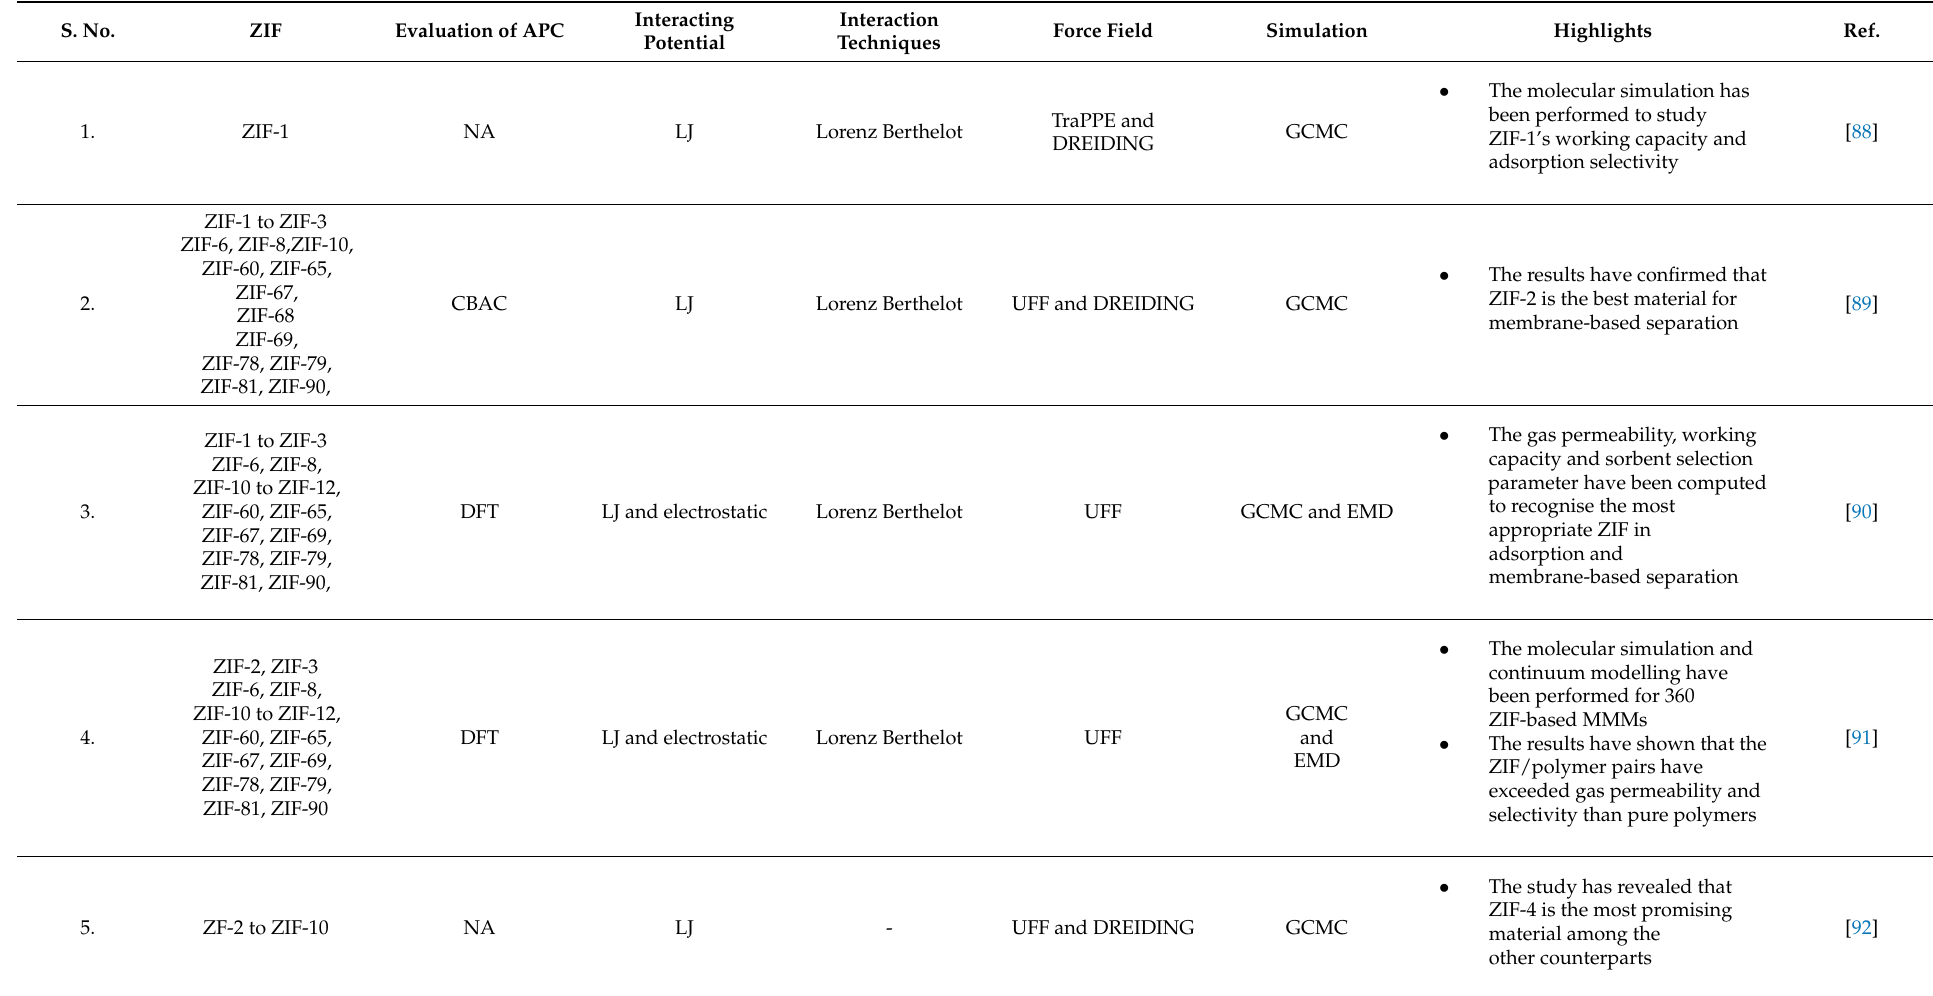
Table 9. The essential parameters and techniques during modelling and simulations of different